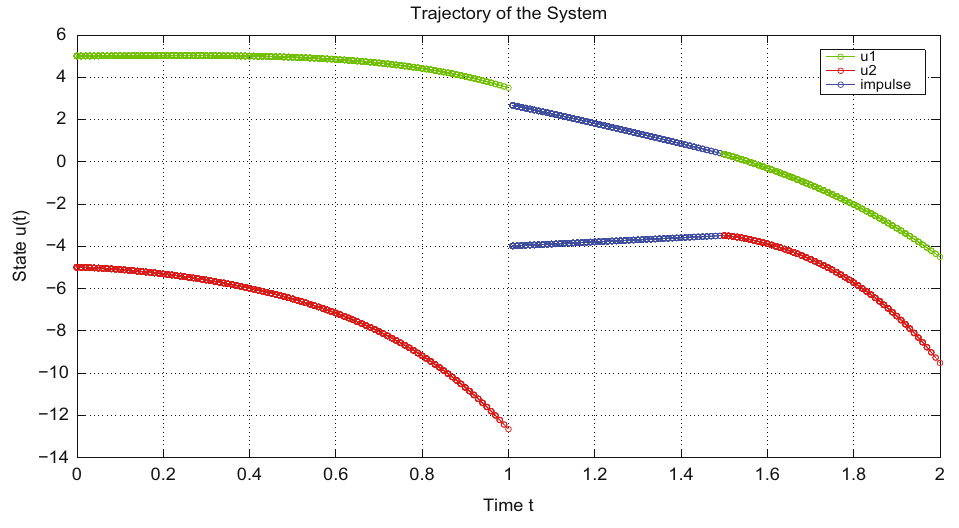
5   and does not reach the fi nal state   − 5